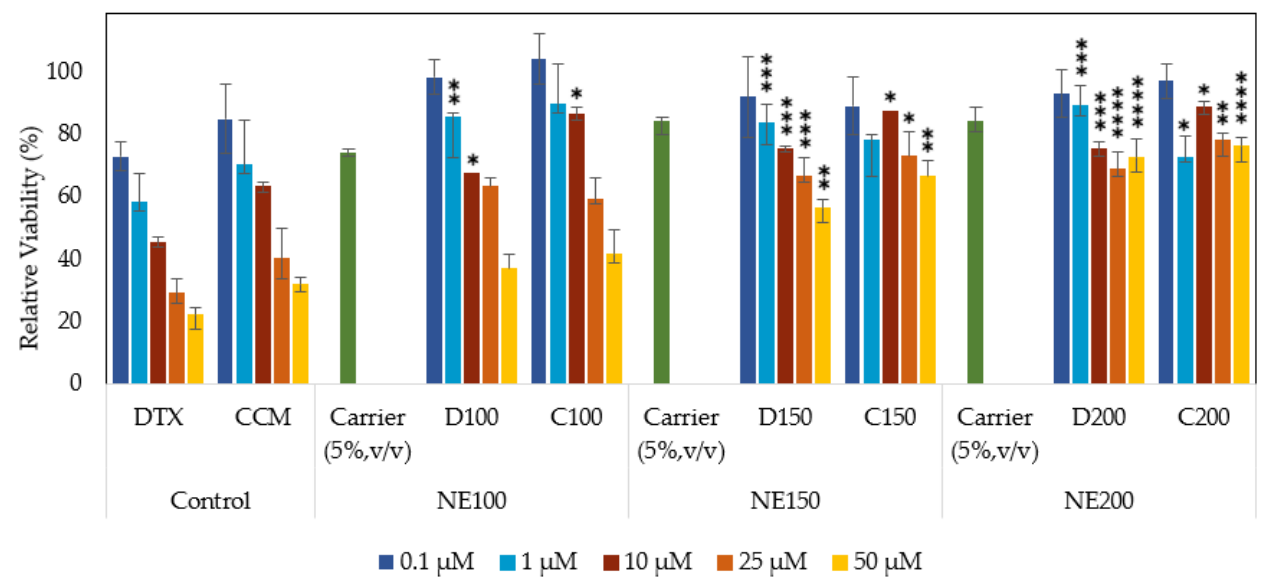
Figure 7. Cell viability of human lung fibroblast (MRC-5) cells analyzed by the MTT assay. Cells were incubated for 48 h at 37 ± 1 ◦ C with different concentrations of controls and different size DTX- and CCM-loaded nanoemulsions (100, 150, and 200 nm). Error bars denote standard deviation ( n = 3), and asterisks denote statistically significant differences between DTX- and CCM-loaded nanoemulsions with their respective control (**** p < 0.0001; *** p < 0.001; ** p < 0.01; * p < 0.05). DTX: Docetaxel; CCM: Curcumin; NE100: Nanoemulsion with a size of 100 nm; NE150: Nanoemulsion with a size of 150 nm; NE200: Nanoemulsion with a size of 200 nm.